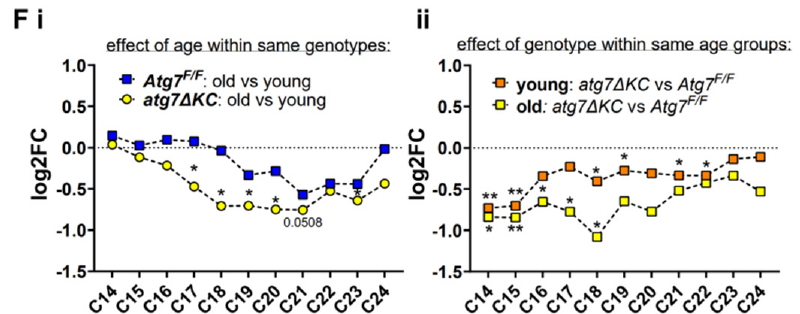
Figure 2. Individual triacylglycerol (TAG) species are mainly upregulated in the tail epidermis of aged mice. B TAG levels remain unchanged in the young knockout epidermis but are decreased in aged knockout, compared to the age-matched control epidermis. Panels show fold change of individual TAG species ( A ) in aged animals compared to their young counterparts and ( B ) in animals of different genotypes but of comparable age. Student’s t -test, log fold change (mean of replicate values of the given group divided with a mean of replicates of a reference group). * marks a significant difference compared to the reference group; * p < 0,05, ** p < 0,01; n = 4 (for Atg7f/f young and old, and atg7 ∆ KC young) and 5 (for atg7 ∆ KC old). ( C , D ) Profile of cholesterol esters (CE) identified in murine epidermal extracts. C Absolute amounts are expressed as pmol/mg of hydrated epidermal tissue. Two-way ANOVA with Bonferroni’s multiple comparisons test, mean standard ± deviation. * marks a significant difference compared to the control group (Atg7 F/F young), + shows a significant difference between two respective groups indicated by a line segment; * p < 0,05, ** p < 0,01, +++ p < 0.001; n = 4 (for Atg7f/f young and old, and atg7 ∆ KC young) and 5 (for atg7 ∆ KC old). The inserted parts of a whole diagram show an individual species proportion within the CE class identified in the young control group. For CE species distribution in other groups studied see Supplementary Information, Figure S1. ( D ) Panels show fold change of individual CE species ( i ) in aged animals compared to their young counterparts and ( ii ) in animals of different genotype but of comparable age. Student’s t -test, log fold change (mean of replicate values of given group divided with a mean of replicates of a reference group). * marks a significant difference compared to the reference group; * p < 0.05, ** p < 0.01; n = 4 (for Atg7f/f young and old, and atg7 ∆ KC young) and 5 (for atg7 ∆ KC old). ( E , F ) Acyl chain distribution within the sphingomyelin (SM) class was identified. E SMs with identical carbon numbers are combined (assuming that the sphingoid base has 18C, e.g. predicted C16 = SM d34:x); for the complete SM species overview see Supplementary Figure S2. Absolute amounts are expressed as pmol/mg of hydrated epidermal tissue. Two-way ANOVA with Bonferroni’s multiple comparisons test, mean standard deviation. * marks a significant ± difference compared to the control group (Atg7 F/F young), + shows a significant difference between two respective groups indicated by a line segment; */+ p < 0,05, ** p < 0.01, ***/+++ p < 0.001; n = 4 (for Atg7f/f young and old, and atg7 ∆ KC young) and 5 (for atg7 ∆ KC old). The inserted parts of the whole diagram show the proportion of predicted acyl chain lengths within the SM class in the control group. For SM chain length distribution in other groups studied see Supplementary Information, Figure S3. ( F ) Panels show fold change of individual SM species with the identical carbon number species ( i ) in aged animals compared to their young counterparts and ( ii ) in animals of different genotype but of comparable age. Student’s t -test, log fold change (mean of replicate values of the given group divided with a mean of replicates of a reference group). * marks a significant difference compared to the reference group; * p < 0.05, ** p < 0.01; n = 4 (for Atg7f/f young and old, and atg7 ∆ KC young) and 5 (for atg7 ∆ KC old). Note: Data presented in panels ( A , B , D , F ): symbols connected with a dashed line were chosen here only for a better visual depiction of trends or significant patterns and their